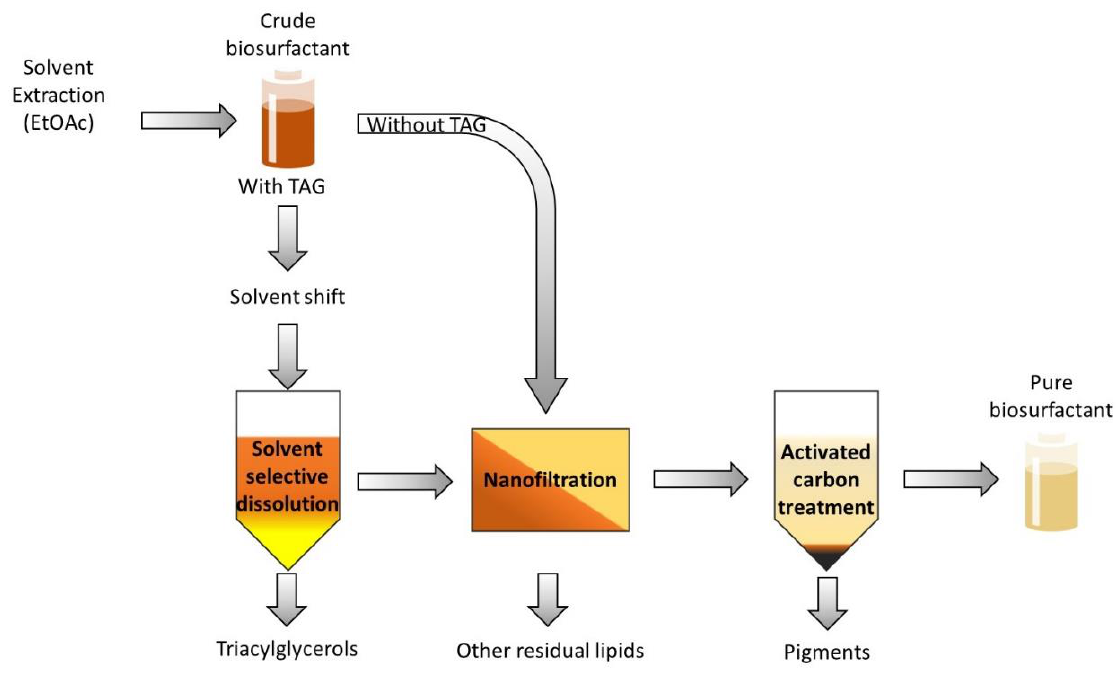
Figure 1. Schematic representation of the proposed downstream process for glycolipid biosurfactants produced from hydrocarbon- and lipid-based substrates.